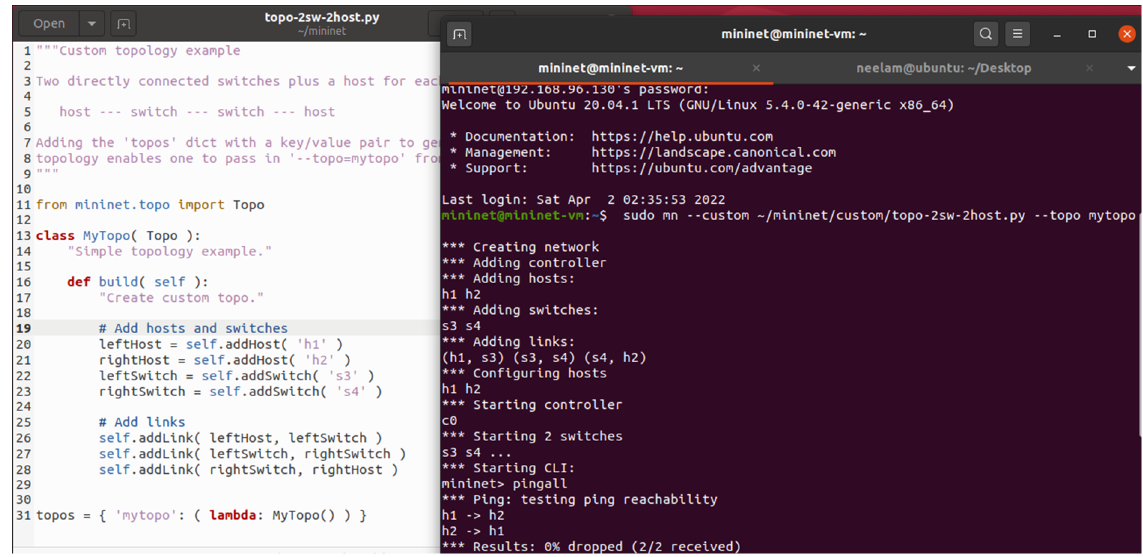
Figure 18. Reverse topology Mininet command: mn ‐‐ topo reversed,3.